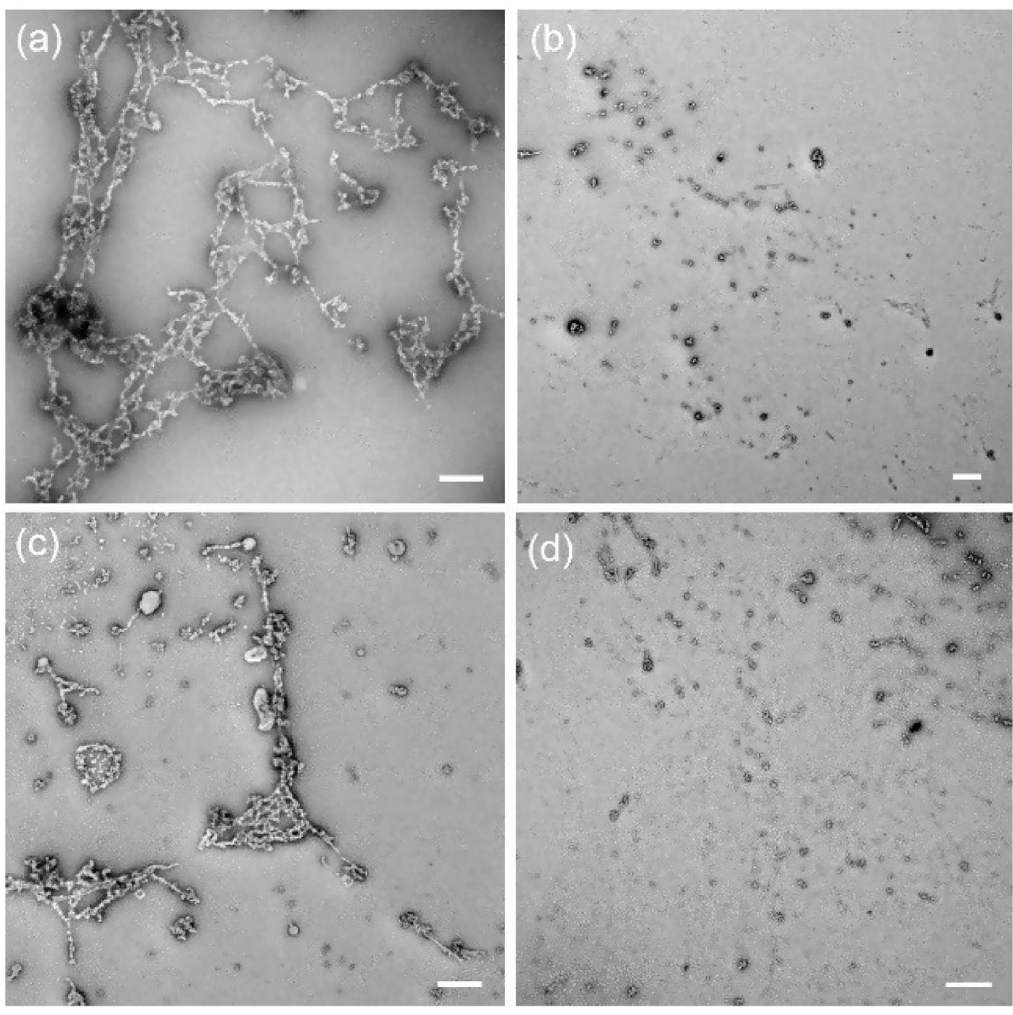
Figure 24. TEM images of βCD -C6-Azo aqueous solution (1 mM): ( a ) original solution; ( b ) original solution irradiated by 360 nm UV light; ( c ) original solution irradiated by 360 nm UV light and then visible light; ( d ) original solution irradiated by 360 nm UV light and then visible light and then UV light. The scale bar = 0.5 μ m. Reuse (reprint) with permission of Guo, H.; Jiang, B.; Zhou, J.; Zhao, L.; Xu, B.; Liu, C. Self- Assembly of β -Cyclodextrin-Derived Amphiphile with a Photo Responsive Guest. Colloids Surf. A Physicochem. Eng. Asp. 2019 , 579 , 123683, doi:10.1016/j.colsurfa.2019.123683. Copyright (2019) Elsevier.